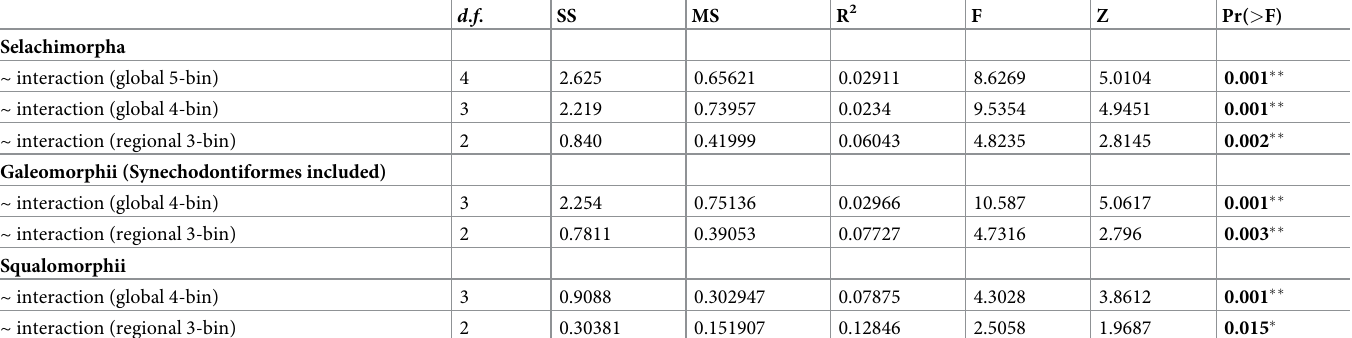
Table 2. Nonparametric analysis of variance based on RRPP for all PCs. Coefficient estimation via OLS. Type I (sequential) sums of squares were used to calculate sums of squares and cross-products matrices. Effect sizes (Z) based on F